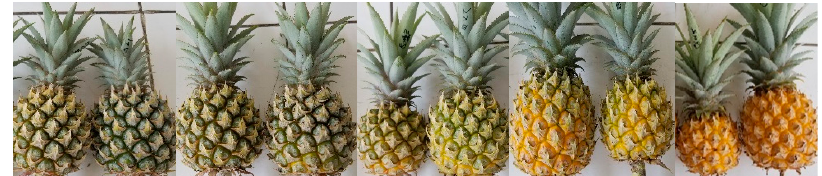
Figure 1. Pineapple sample from all ripening stages. From left to right: C0 until C4 stages. This classification is based on the peel color of pineapple, in which C0 stage contains 0% yellow color, C1 stage contain 0%–25% yellow color, C2 stage contain 25%–50% yellow color, C3 stage contain 50%–75% yellow color, and C4 stage contain 75%–100% yellow color [5].